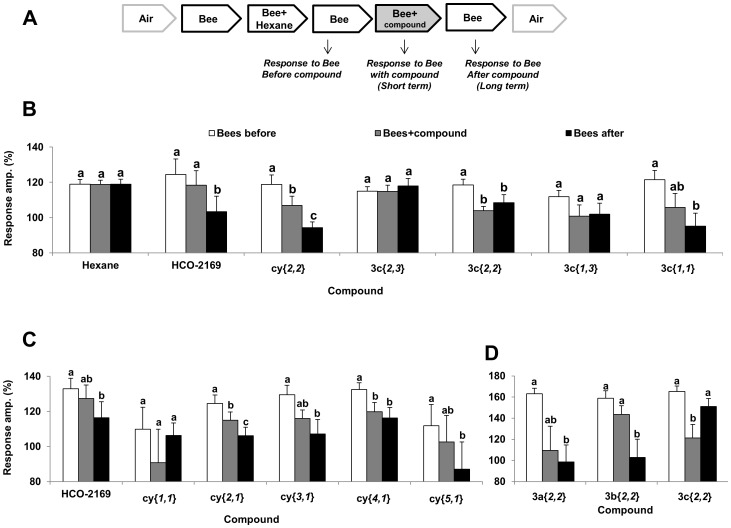
Electrophysiological screening of the compounds.
A. Order of the Varroa foreleg stimulations and terminology used for the corresponding responses. The time interval between each stimulus was 30 s, unless otherwise stated. The stimuli were: Air, Headspace of five nurse bees (bee stimulus), Bee stimulus together with the compound (Bee stimulus + comp) or of the hexane control (Bee stimulus + hexane). In italics, below the stimuli, are the names of the values presented in the results. B. Initial screen of the Varroa foreleg electrophysiological response to different stimuli, all loaded at 10 µg in the stimulus cartridge (normalized values against the response to air %, average+SE). For the bee stimuli, the headspace from 5 nurse bees was used. Bars marked by different letters are significantly different, ANOVA repeated measures, p<0.05, n = 10.C. Testing of the individual components of the blend HCO-2169 at 10 µg doses (n = 10). D. Experiment with the three isomers of diethyoxybenzene at 10 µg doses (n = 6).